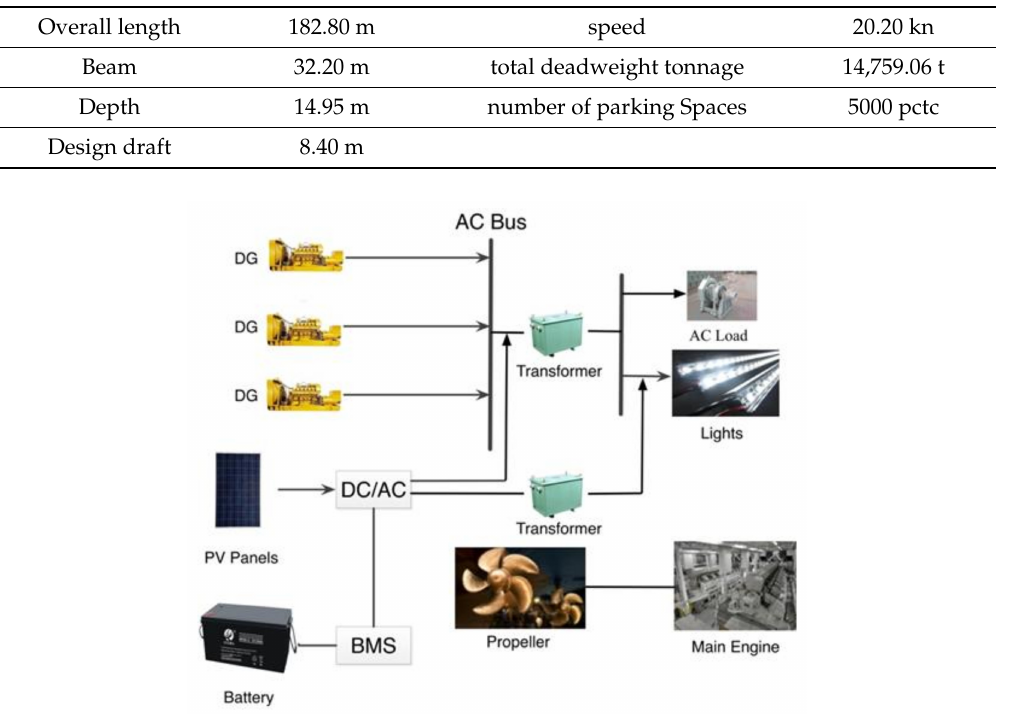
Figure 1. A flowchart of the solar-diesel generator hybrid